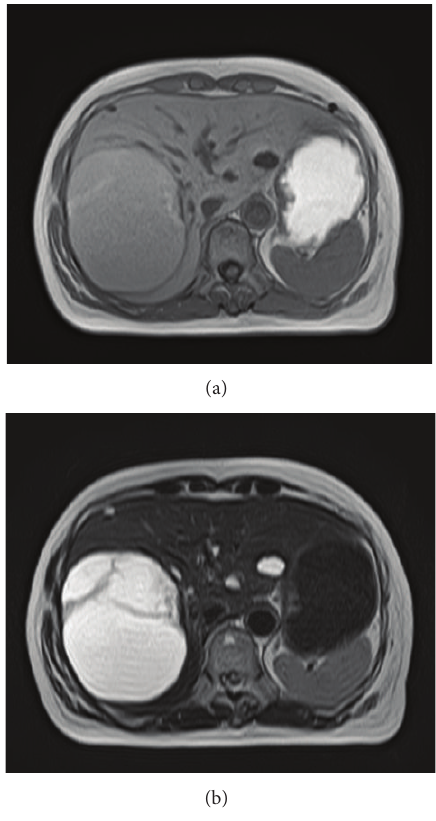
Figure 4: Abdominal magnetic resonance imaging and magnetic resonance cholangiopancreatography performed in February 2012. (a)T1-weightedand(b)T2WIimages.Thesignalintensitywithinthe cystic mass is stronger than that of simple cysts on the T1-weighted image. In addition, multilocular septal structures and nodular solid components are visible at the base. There is no clear communication with the intrahepatic bile ducts. Figure 5: The resected